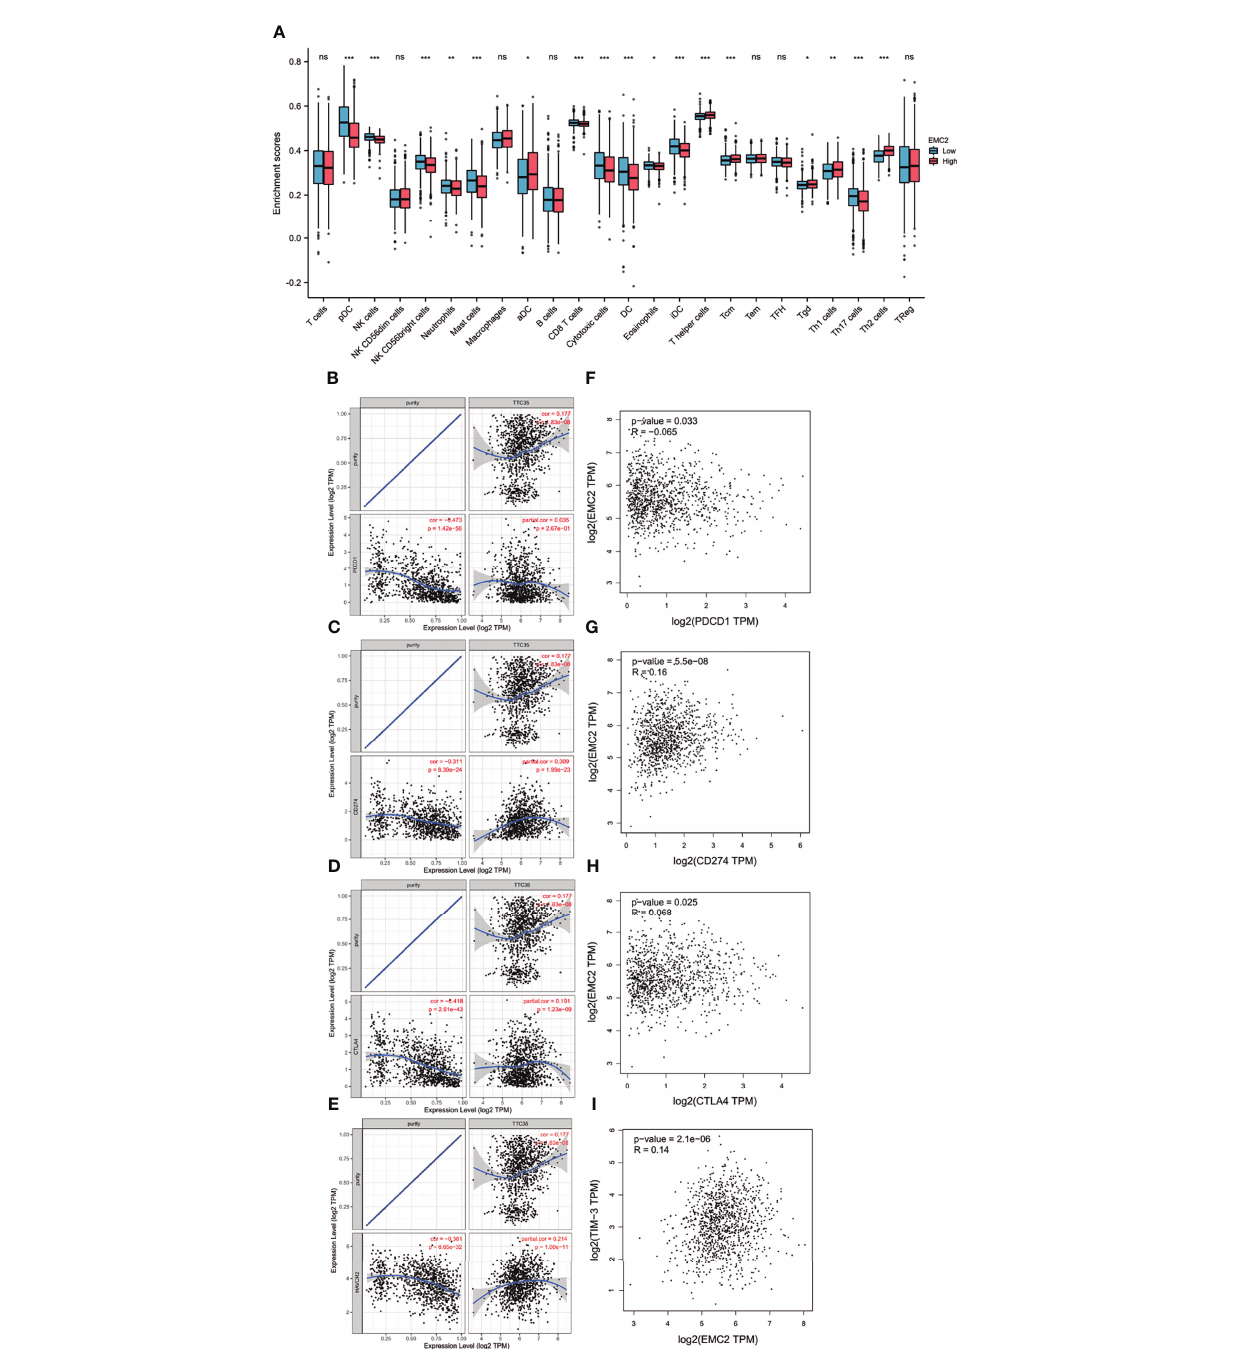
FIGURE 7 | The relationship of immune cell in fi ltration with EMC2 expression and correlation of EMC2 expression with PD-1, PD-L1, CTLA-4 and TIM-3 expression in BRCA. (A) Correlation of EMC2 expression with the in fi ltration of different immune cells in BRCA. (B) Spearman correlation of EMC2 with expression of PD-1 in BRCA adjusted by purity using TIMER. (C) Spearman correlation of EMC2 with expression of PD-L1 in BRCA adjusted by purity using TIMER. (D) Spearman correlation of EMC2 with expression of CTLA-4 in BRCA adjusted by purity using TIMER. (E) The expression correlation of EMC2 with TIM-3 in BRCA adjusted by purity using TIMER. (F) The expression correlation of EMC2 with PD-1 in BRCA determined by GEPIA database. (G) The expression correlation of EMC2 with PD-L1 in BRCA determined by GEPIA database. (H) The expression correlation of EMC2 with CTLA-4 in BRCA determined by GEPIA database. (I) The expression correlation of EMC2 with TIM-1 in BRCA determined by GEPIA database. ns, not; signi fi cant; *P < 0.05; **P < 0.01; ***P <